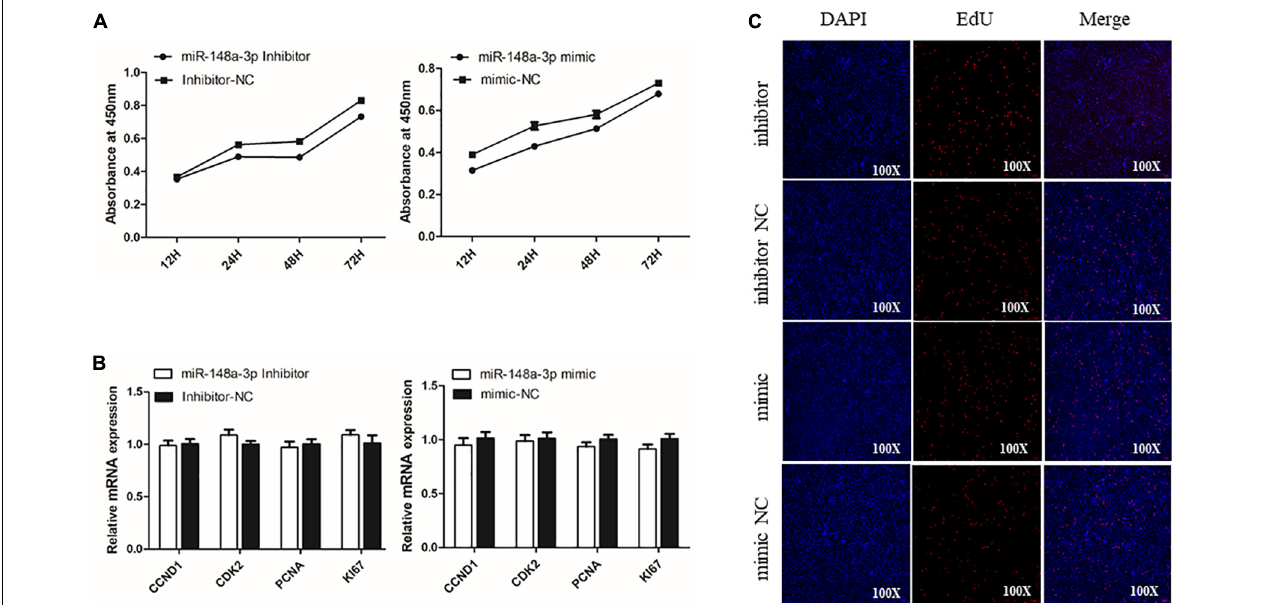
FIGURE 3 | Effect of miR-148a-3p on the proliferation of SMSCs. (A) Cell growth curves as measured using the CCK-8 assay following transfection with a miR-148a-3p mimic, inhibitor or negative control in SMSCs. (B) Results of Edu assay for SMSCs transfected with a miR-148a-3p mimic, inhibitor, or negative control, where EdU (red) fluorescence is used as an indicator of proliferation and nuclei are indicated by Hoechst (blue) fluorescence. Photomicrographs were taken using a 100 × magnification. (C) mRNA expression of CCND1 and PCNA in SMSCs transfected with a miR-148a-3p mimic, inhibitor, or negative control. Data are expressed as mean ± SEM ( N =